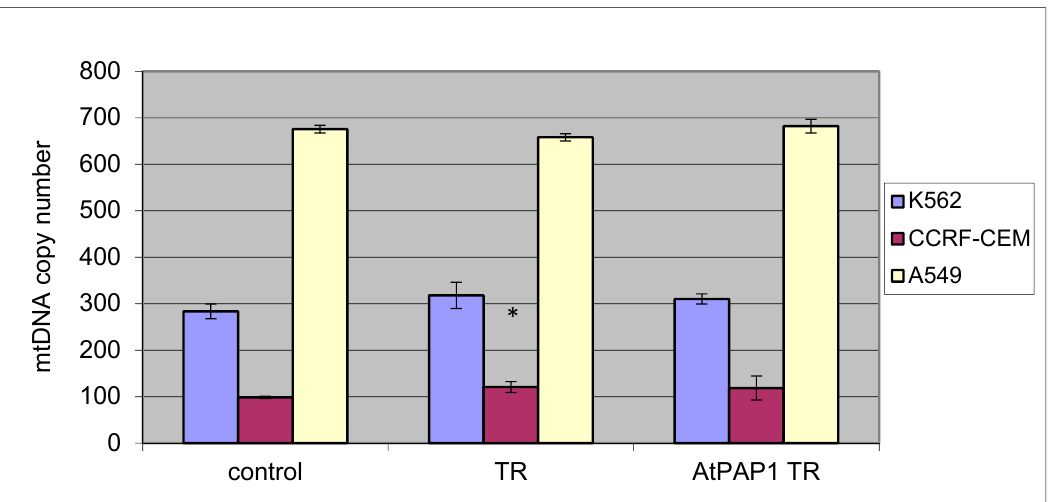
Figure 3. The effect of TR and AtPAP1 TR root extracts of L. sibiricus on mitochondrial DNA copy number in an CCRF-CEM, K562 and A549 cell line measured by real-time quantitative PCR. The data represent means ± SD. *: p < 0.05 Control vs. TR and AtPAP1 TR. #: p < 0.05 TR vs AtPAP1 TR.